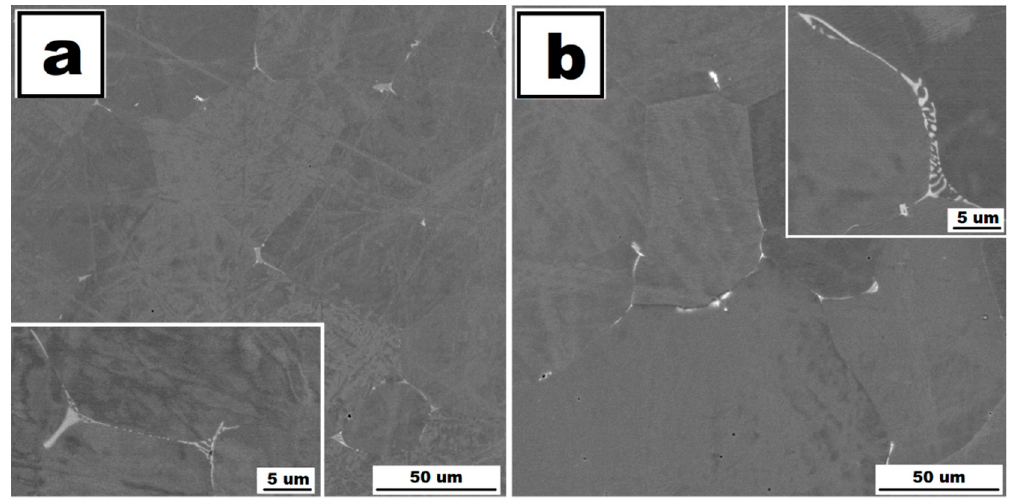
Figure 5. The structure of Fe28Al5Si2Ti alloy in as-cast state ( a ) and the structure of Fe28Al5Si2Ti alloy after annealing at 800 °C for 100 h ( b )—(SEM, BSE, 20 kV).